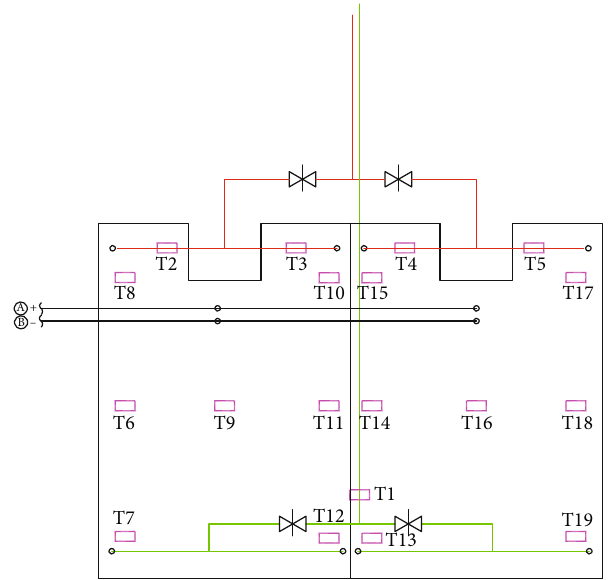
Figure 2: Location of the measuring points set on the absorber plate.